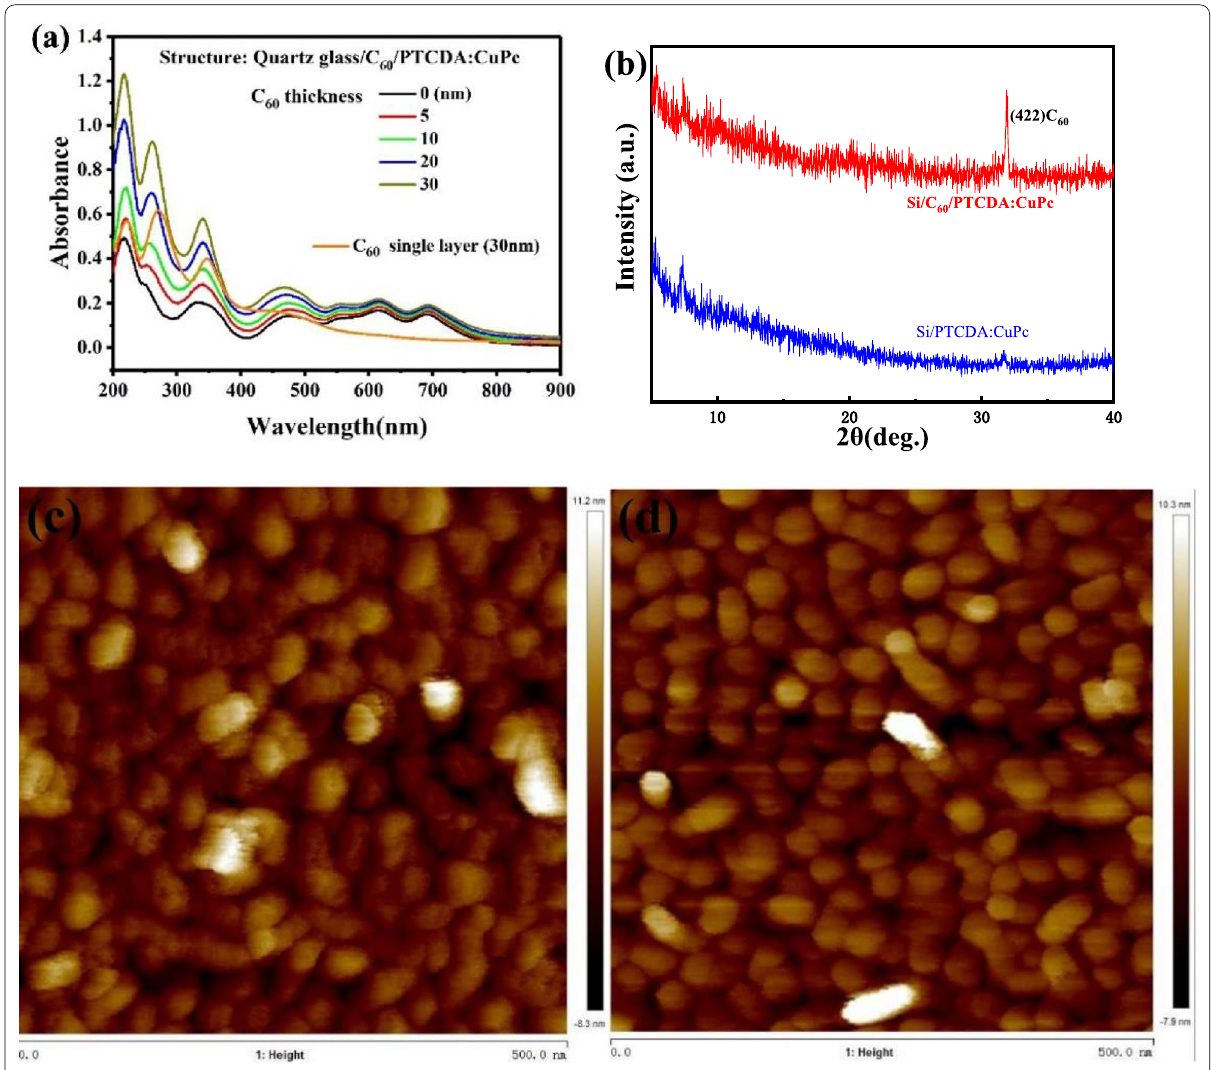
Fig. 2 a Optical absorption spectra of C 60 single layer (30 nm) and PTCDA:CuPc (30 nm) films deposited on C 60 film of different thicknesses. All films were deposited on quartz glasses. b XRD spectrum of PTCDA:CuPc films with and without C 60 film. And AFM images of c C 60 /PTCDA:CuPc and d PTCDA:CuPc